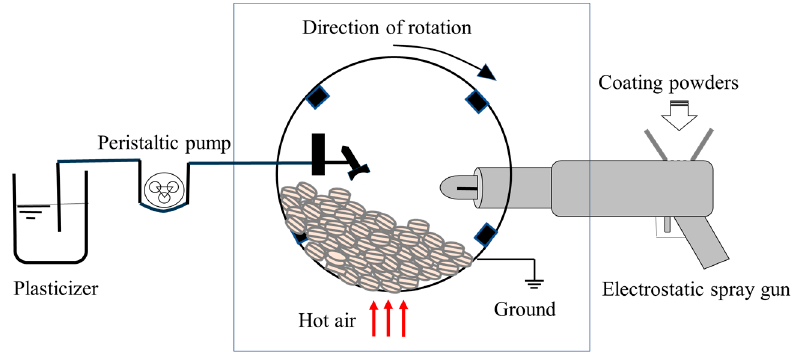
Figure 3. Schematic diagram of the electrostatic powder coating system.